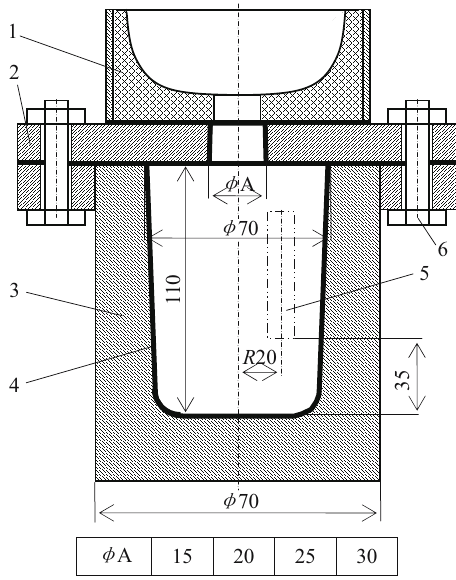
Figure 1: Pouring method of ingot. 1 – pouring cup; 2 – upper cover of ingot mold; 3 – ingot mold; 4 – coating; 5 – impact specimen; 6 – clamp